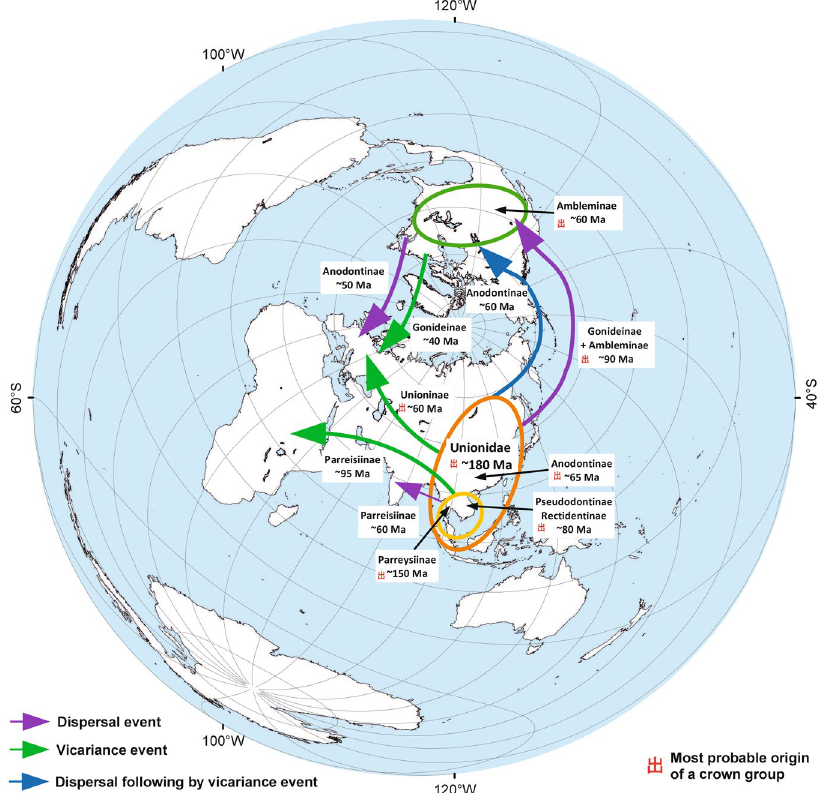
Figure 3. Simplified scheme of origin and expansion routes inferred across clades of the Unionidae. The black numbers near arrows show the timing of putative expansion events (mean age) obtained from the multi-locus fossil-calibrated phylogenetic model (see Fig. 1 and Supplementary Figs 4 and 5 for details). Ellipses indicate the putative places of origin of the family (orange) and several subfamilies (yellow and green). The map was created using ESRI ArcGIS 10 software (www.esri.com/arcgis); the topographic base of the map was created with ESRI Data and